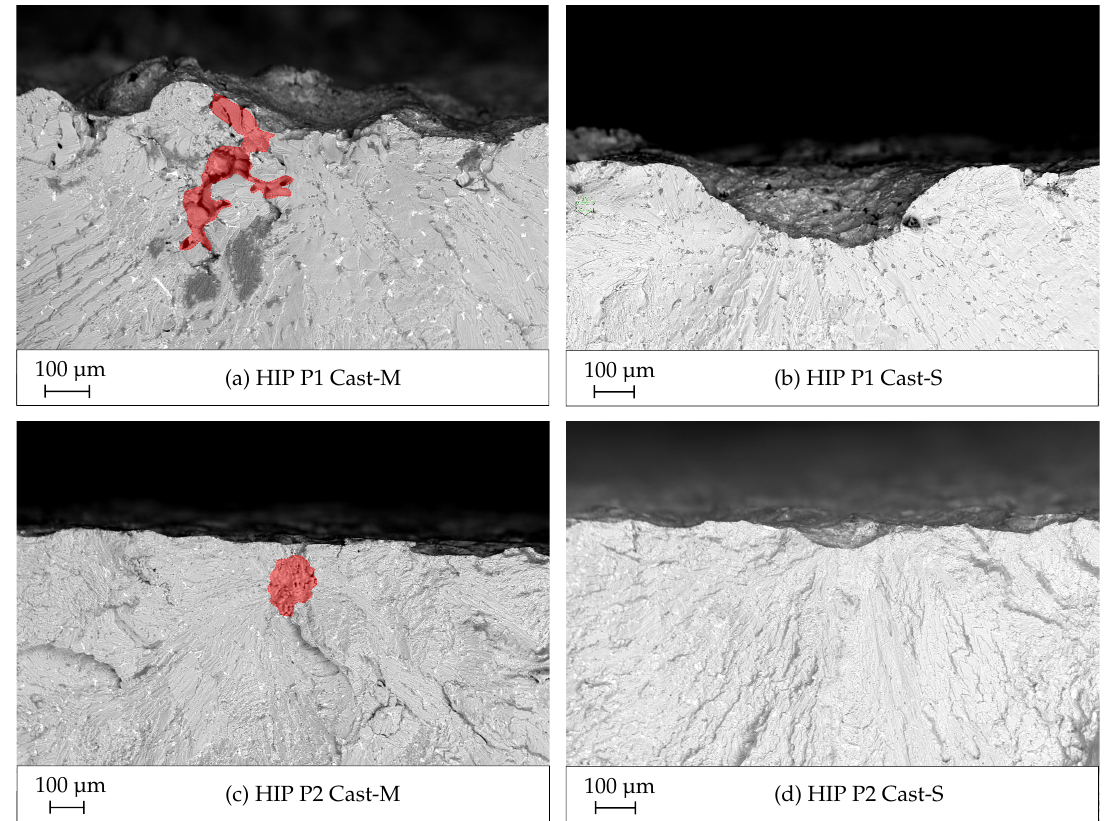
Figure 4. Defect cases: ( a ) HIP P1 cast-M, ( b ) HIP P1 Cast-S, ( c ) HIP P2 Cast-M and ( d ) HIP P2 Cast-S.